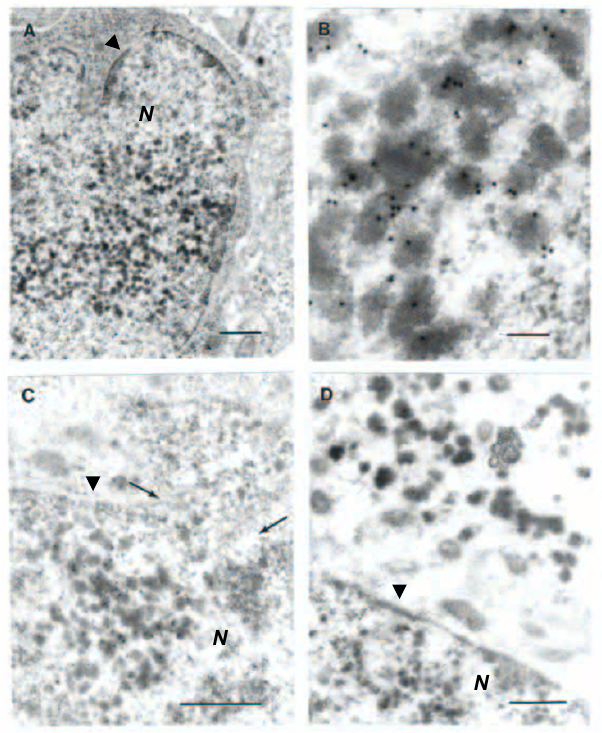
Figure 3 Electron microscopy of inclusion bodies in 293 cells expressing mycRab24(D123I). Cells were harvested 24 h after transfection. Expressed protein was detected with the mouse monoclonal antibody against the myc epitope, fol- lowed by secondary antibody conjugated to 10 nm gold parti- cles. Cells were processed for electron microscopy as described in the Methods. Panel A shows a cell where the majority of immunoreactive inclusions accumulated within nucleus ( N ). Panel B shows the intranuclear inclusions at higher magnification, revealing the individual gold particles concentrated in dense spherical particles of nearly uniform diameter. Panel C shows an example of a cell where disrup- tion of the nuclear envelope was observed (between arrows) in the region near the accumulated intranuclear inclusions. Panel D shows a cell where inclusions were observed in the perinuclear cytoplasm. The dimension bars in each panel are as follows: A, 0.5 micron; B, 0.1 micron; C, 0.5 micron; D, 0.5 micron. The solid arrowheads in panels A, C and D indicate the nuclear